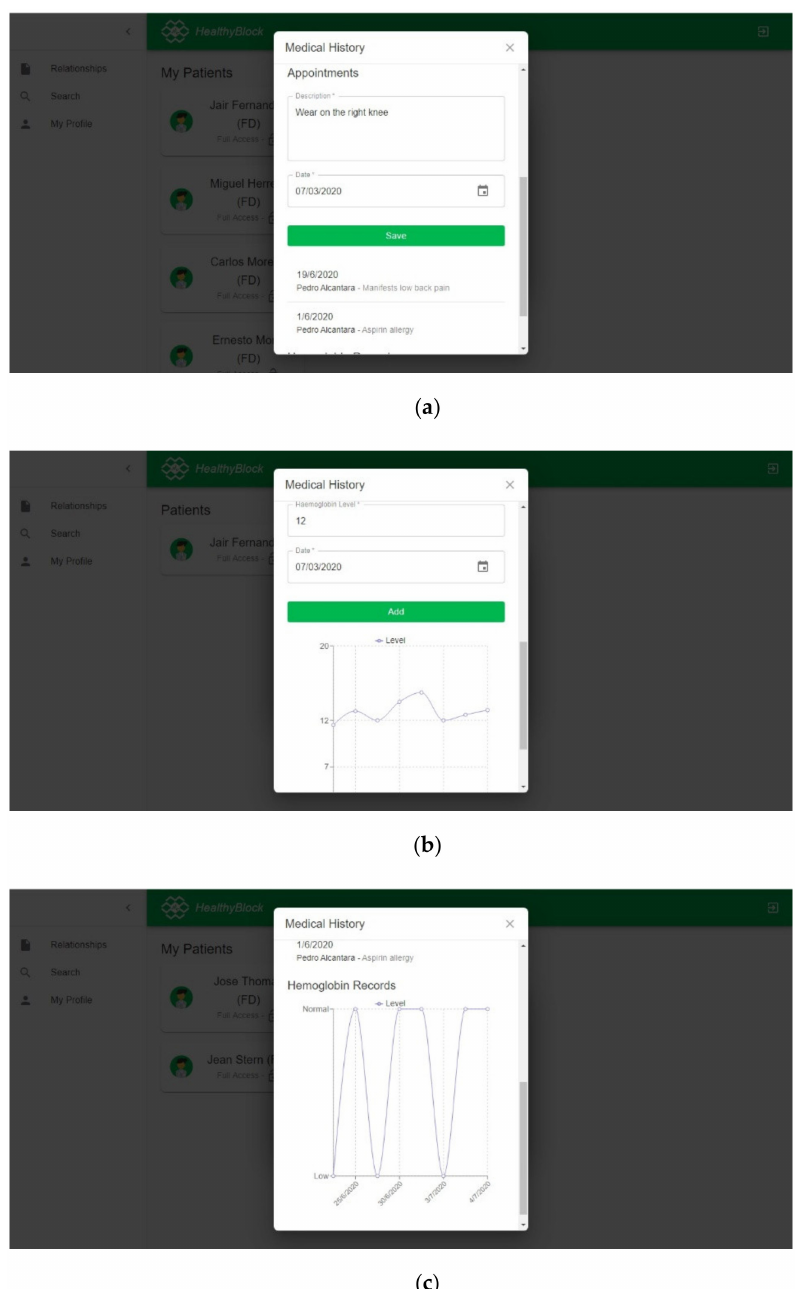
Figure A3. Prototype EMR processes: ( a ) Visualization of medical records; ( b ) Input of hemoglobin data of a patient by a laboratory; ( c ) Visualization of obfuscated